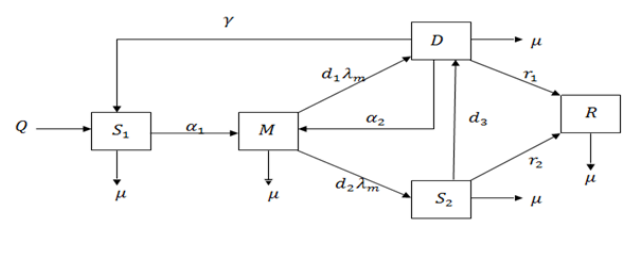
Figure 1. Model flow-diagram of divorce